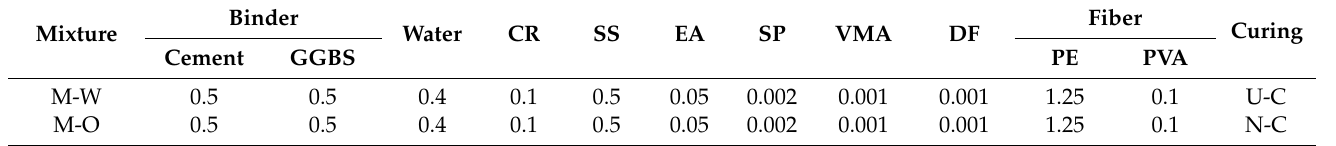
Table 3. Mixture proportions and curing